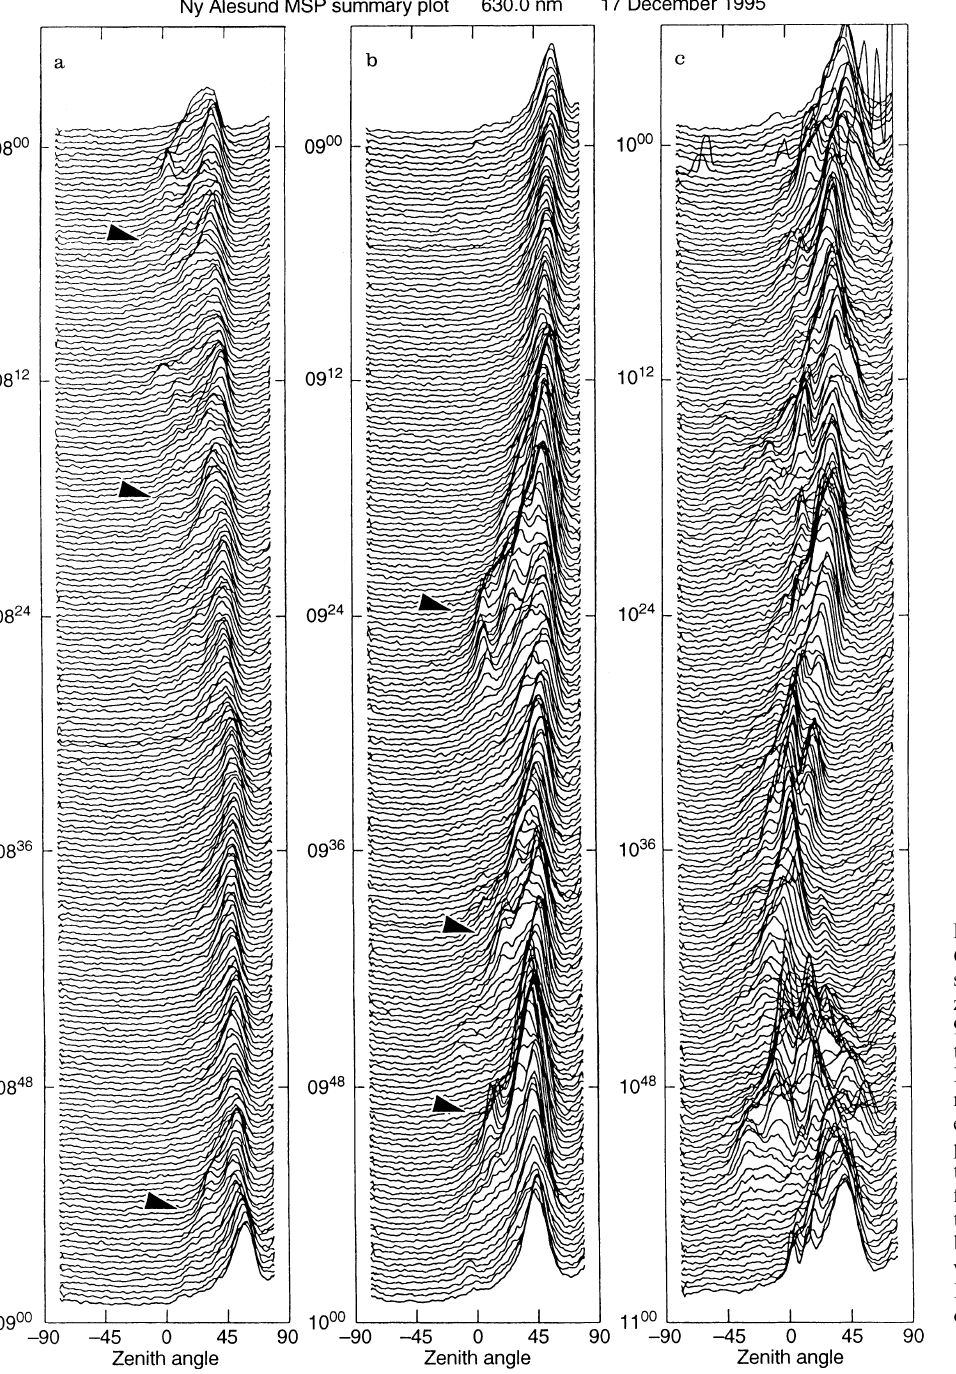
Fig. 3. The Ny A˚ lesund MSP 630 nm (red line) optical emis- sion intensity as a function of zenith angle ( ) 90 (cid:176) to the north, 90 (cid:176) to the south) and UT, be- tween 08 UT and 11 UT, 17 December 1995. Vertical tick marks are equivalent to 1.5 kR emission intensity. Arrows in panel a indicate the times of three poleward-moving auroral forms. Arrows in panel b indicate the times of three transient brightenings of the aurora pole- ward of the continuous arc (see Fig. 4 for the identification of other